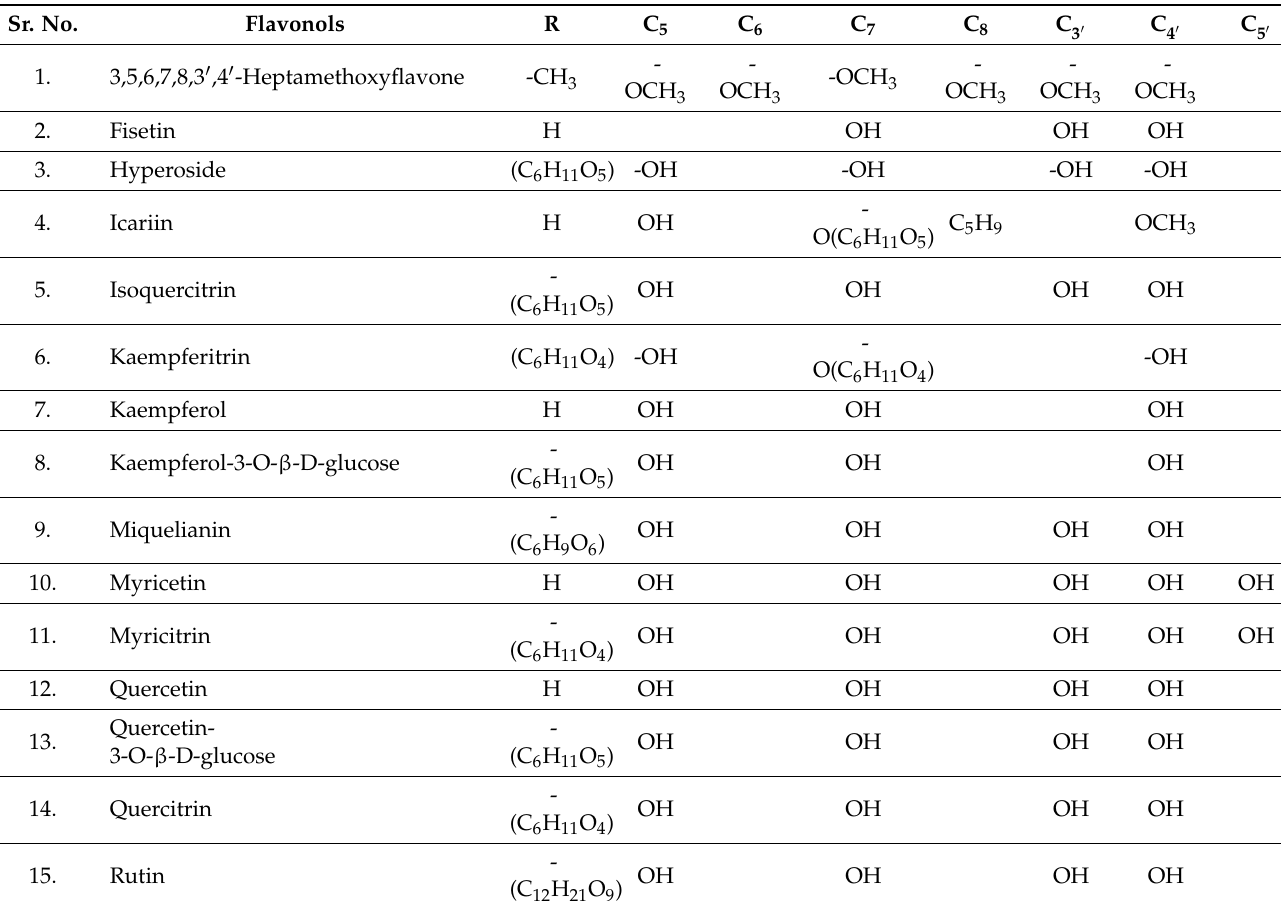
Figure 13. Skeleton of Flavonols. Table 2. Flavonols and their structure activity